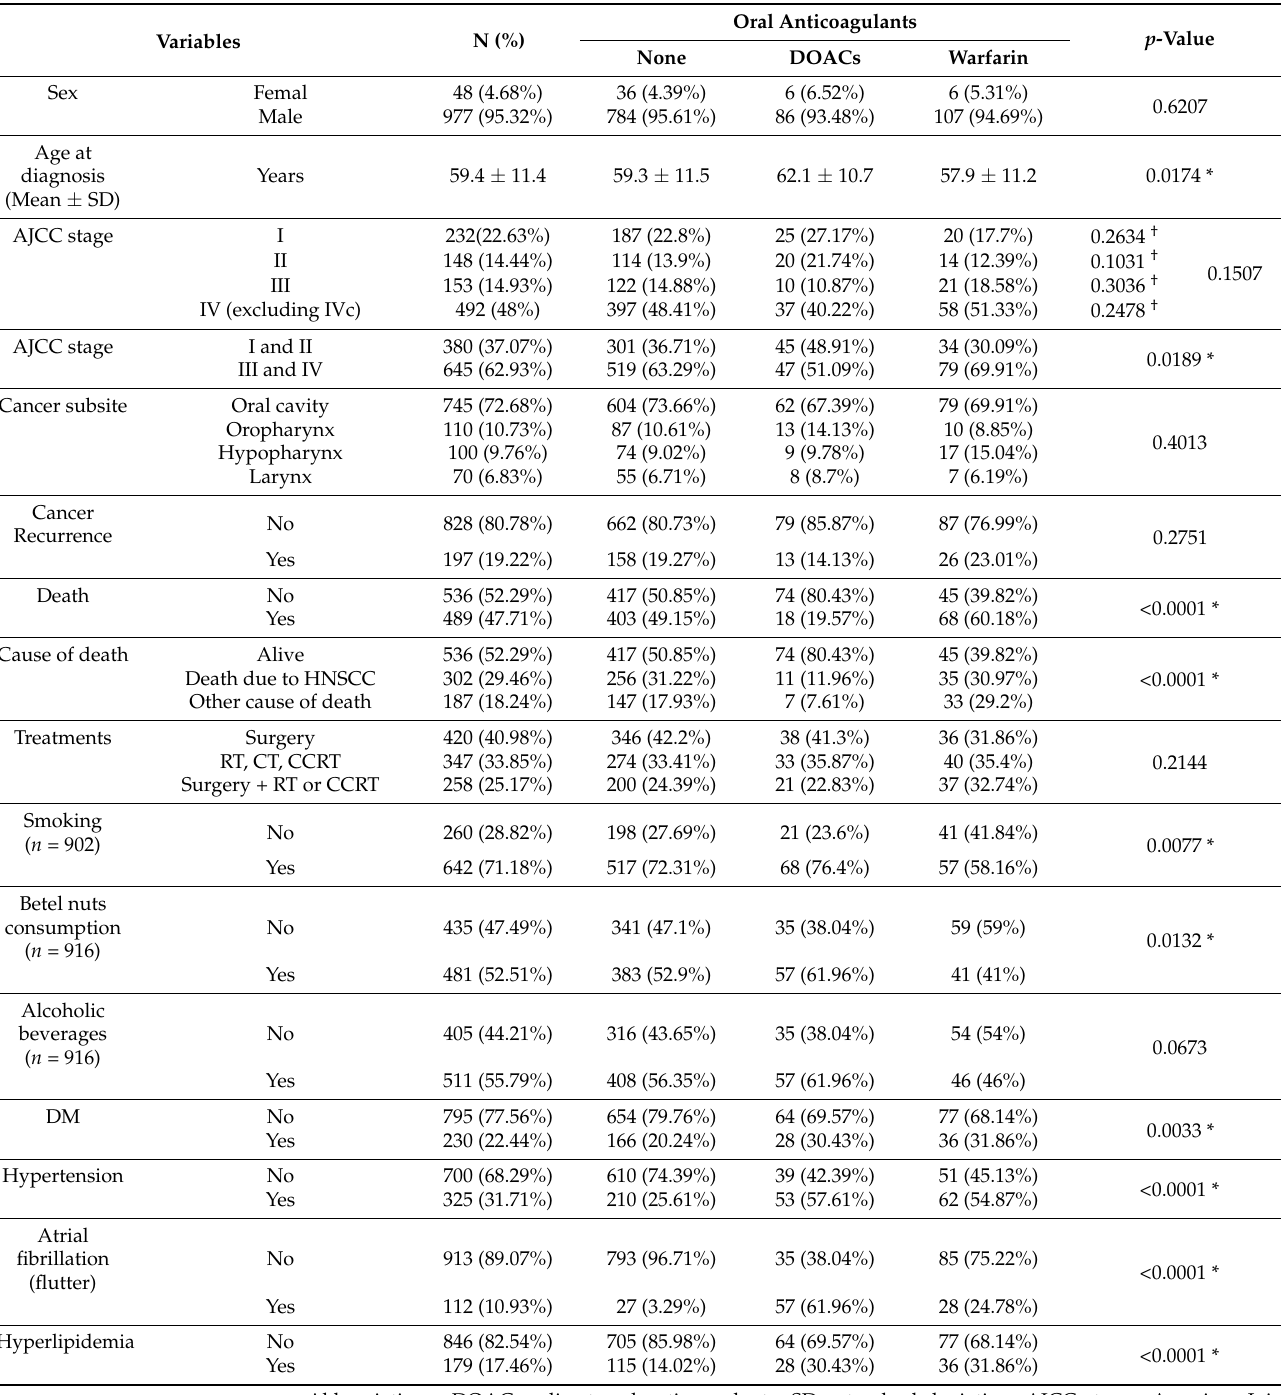
Table 1. Demographic and clinical characteristics of the study cohort ( n =